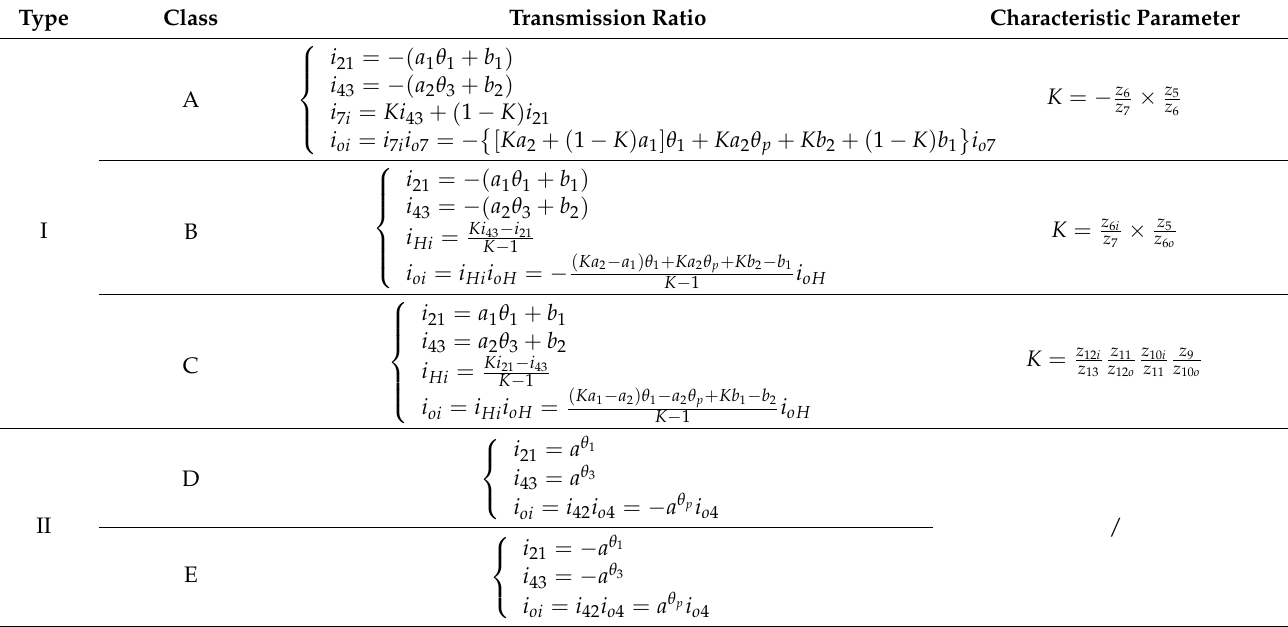
Table 2. Transmission ratio parameter equation of each CVT